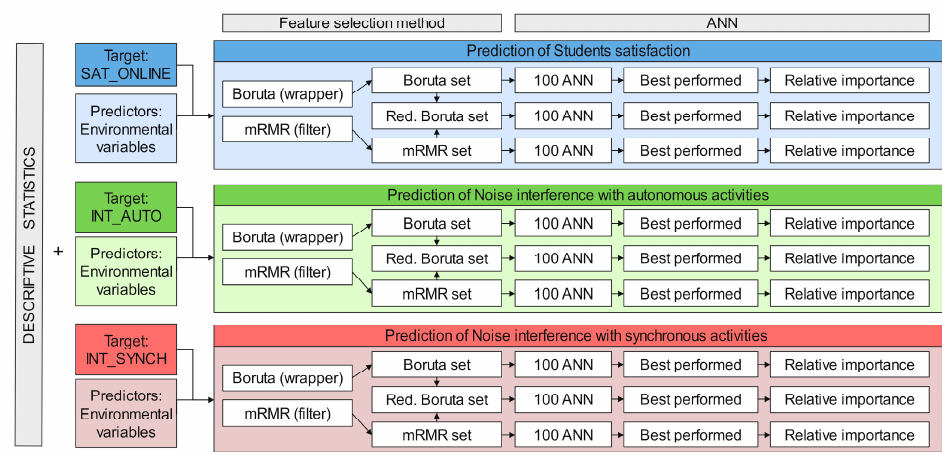
Figure 2. Workflow of the data analysis performed. The target variables of the prediction models are students’ satisfaction with the online learning method (SAT_ONLINE) and the noise interference with autonomous activities (INT_AUTO) and synchronous activities (INT_SYNCH).